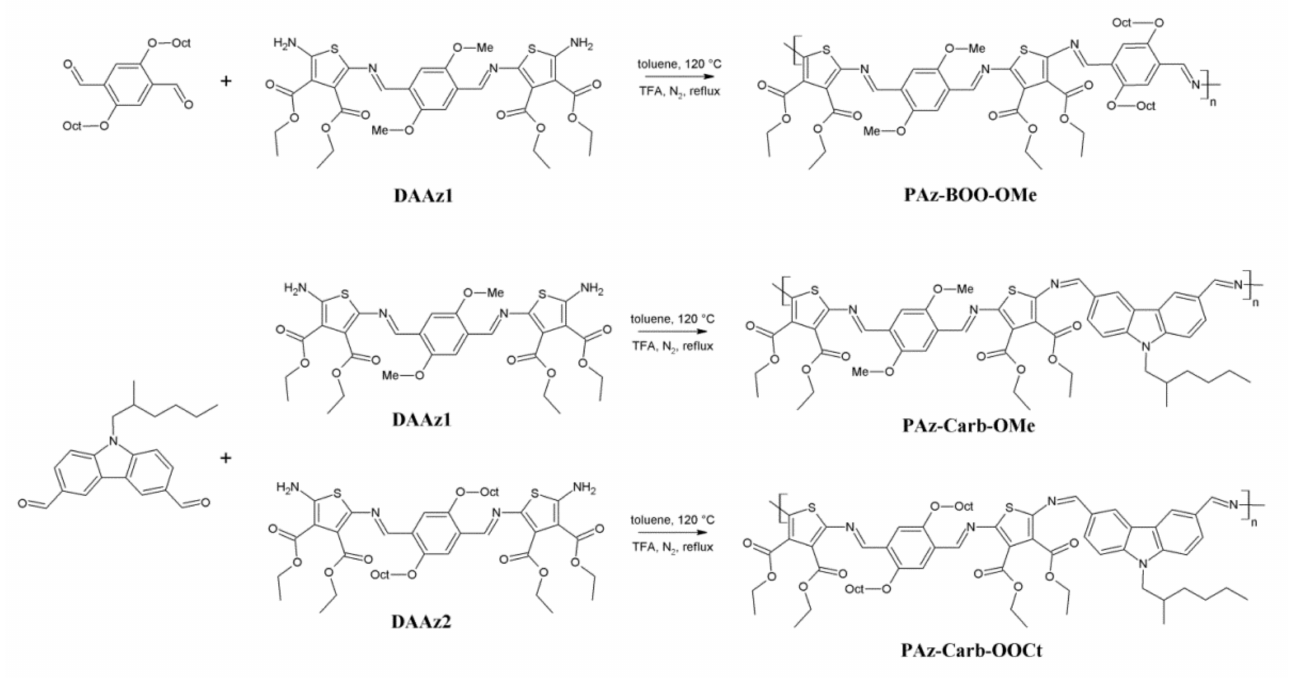
Figure 1. Synthesis procedure and chemical structures of investigated